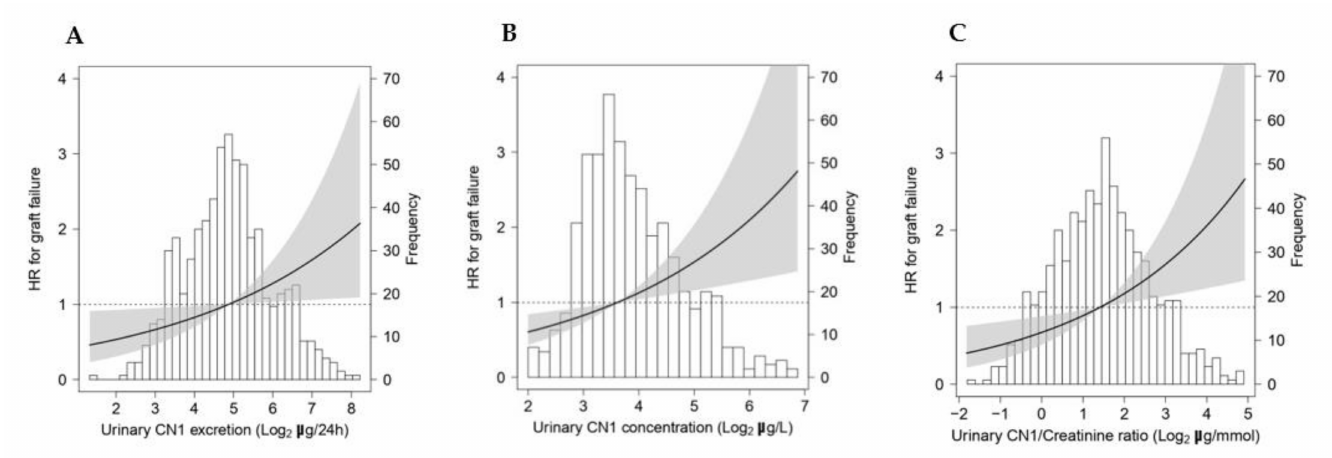
Figure 1. Urinary CN1 and Risk of Graft Failure in KTR. Association of urinary CN1 with death-censored graft failure in KTRs. Continuous association of urinary CN1 excretion A, urinary CN1 concentration B, and urinary CN1/creatinine ratio C with death-censored graft failure in KTRs. Urinary CN1 excretion, urinary CN1 concentrations, and urinary CN1/creatinine ratios were log 2 -transformed for prospective analyses. The histograms depict the distribution. The black line shows the adjusted hazard ratio (HR), and the gray areas correspond to the 95% confidence interval (CI). X-axis represents urinary CN1 excretion and concentration or creatinine ratios, and the y-axis represents the estimated hazard ratio relative to the mean urinary CN1 excretion, concentration, or creatinine ratio as reference values. The adjusted association was adjusted for age, sex, BMI, eGFR, and proteinuria (Model 3). p values were 0.02, 0.003, and 0.005, respectively. Urinary CN1 concentration values below detection level are not shown. Abbreviations: HR: hazard ratio, CN1: